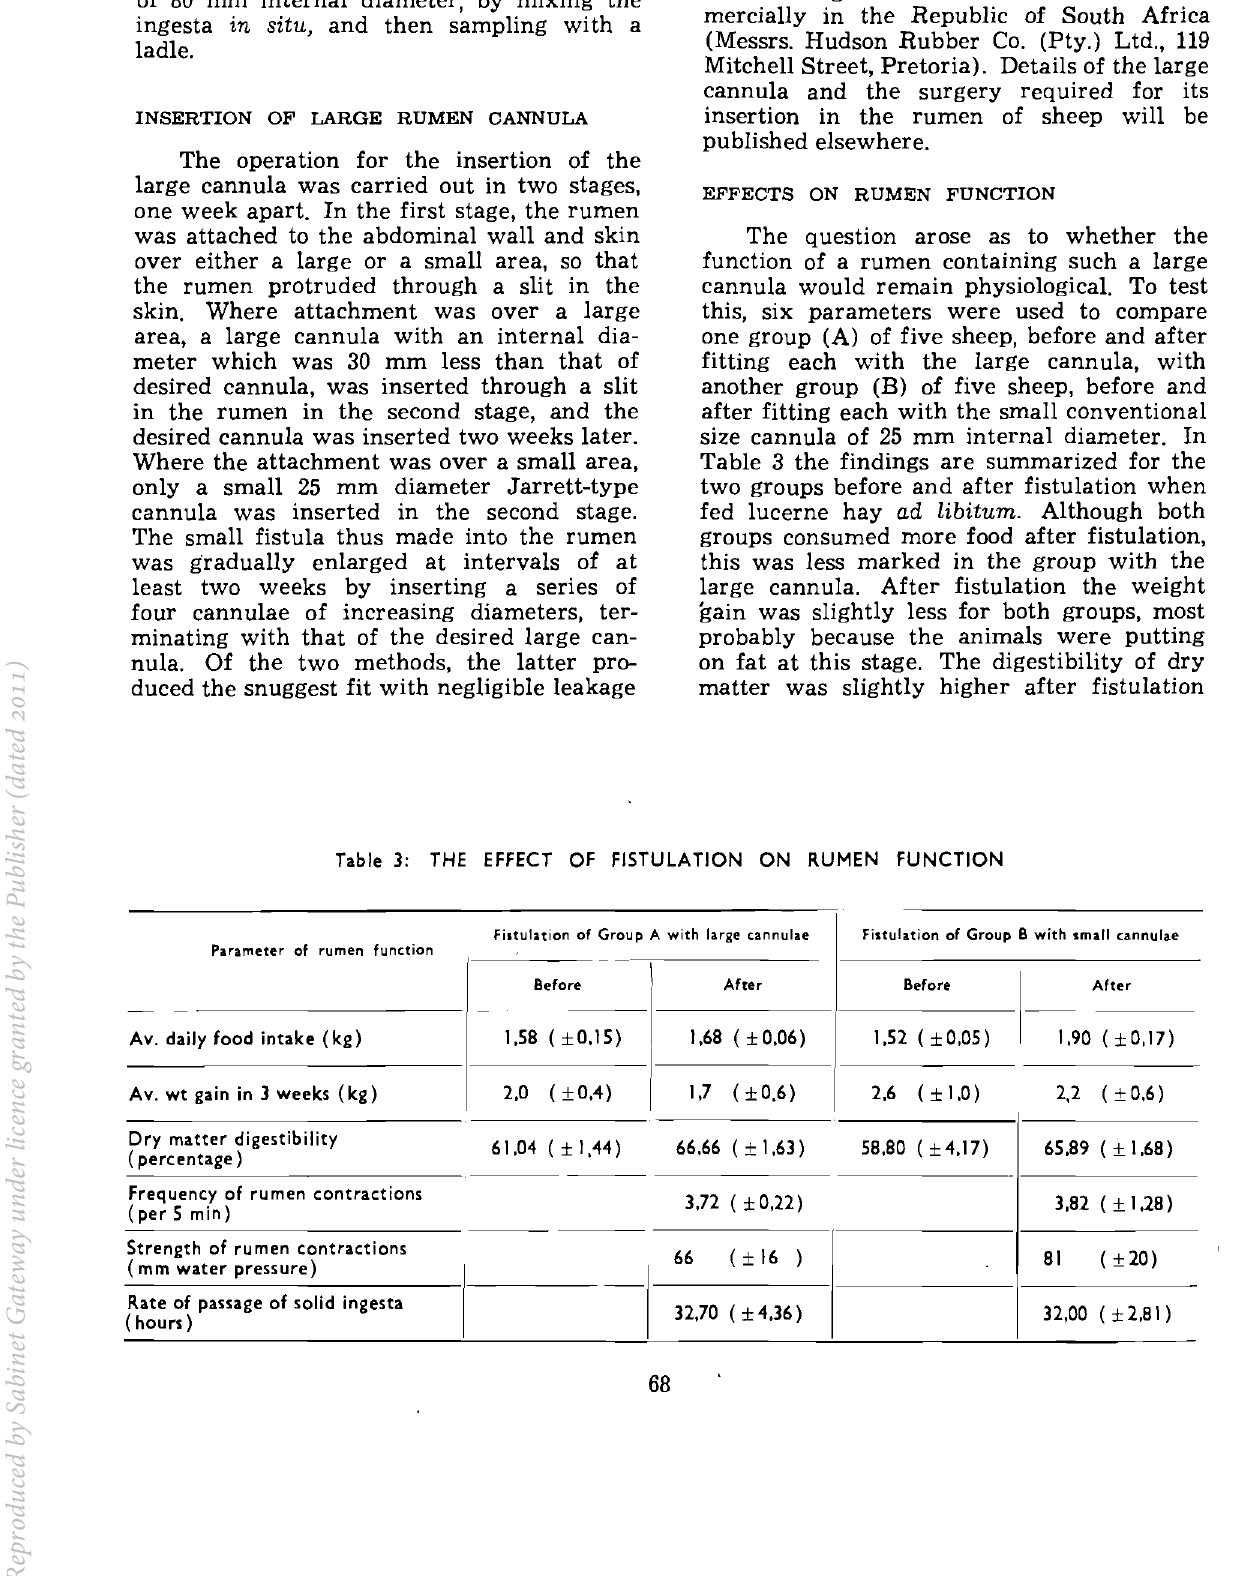
Table 3: THE EFFECT OF FISTULATION ON RUMEN FUNCTION